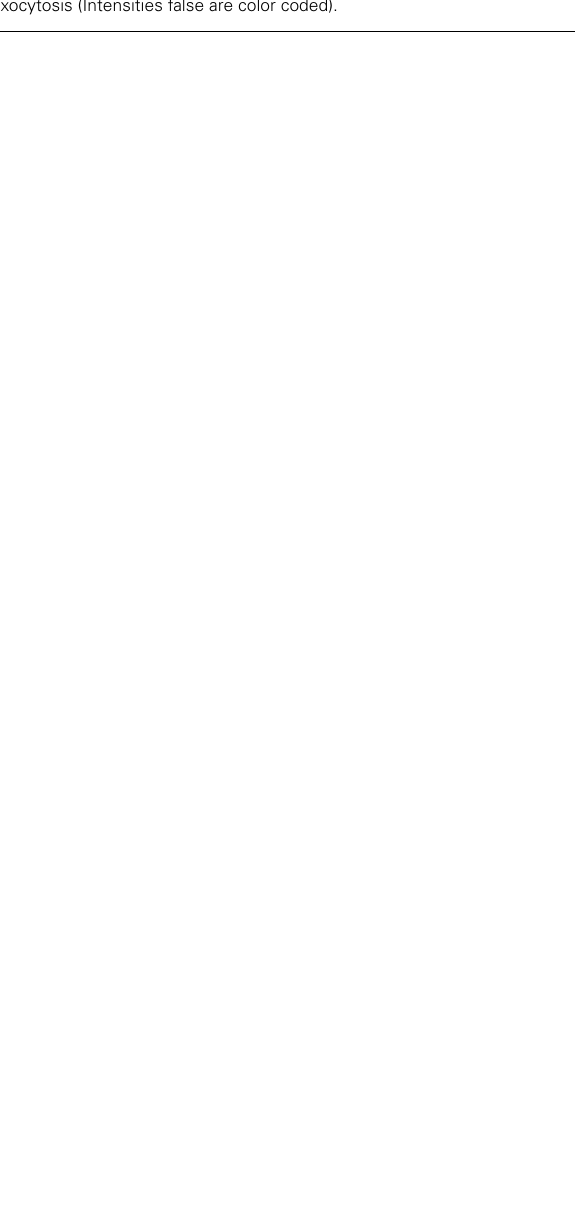
FIGUREA5 | Evidence for individual vesicles leaving a cluster during exocytosis. A three photon serotonin image of a cell at high zoom recorded (A) before and (B) 21min after depolarization.The arrows mark vesicular clusters which appear to lose a fraction of the constituents during exocytosis (Intensities false are color